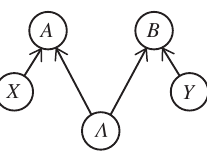
FIG. 2. DAG representing the causal structure of a Bell